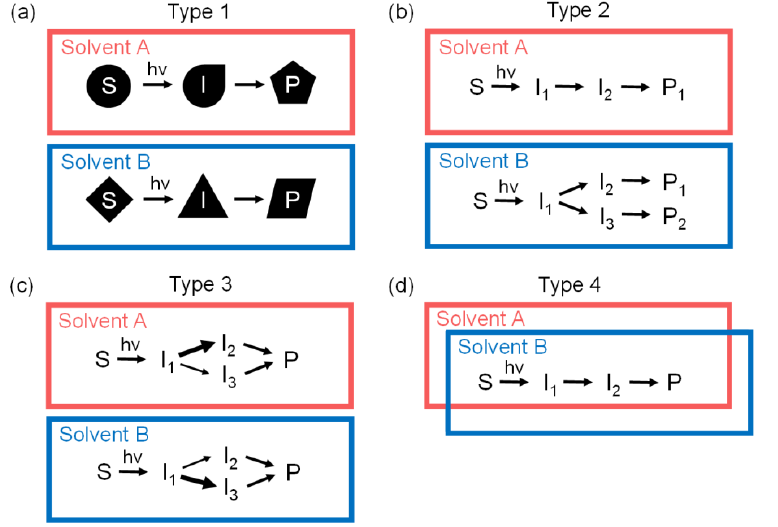
Figure 5. Four different types of solvent dependence of photoreactions. ( a ) In Type 1, the molecular structures of reactants, reaction intermediates, and/or products vary significantly depending on solvent. ( b ) In Type 2, part of the reaction pathway is altered depending on the solvent. ( c ) In Type 3, only the rates or branching ratios of some reaction steps are affected by the change in solvent, while the overall framework of the chemical reaction is maintained. ( d ) In Type 4, no significant differences are observed in different solvents.